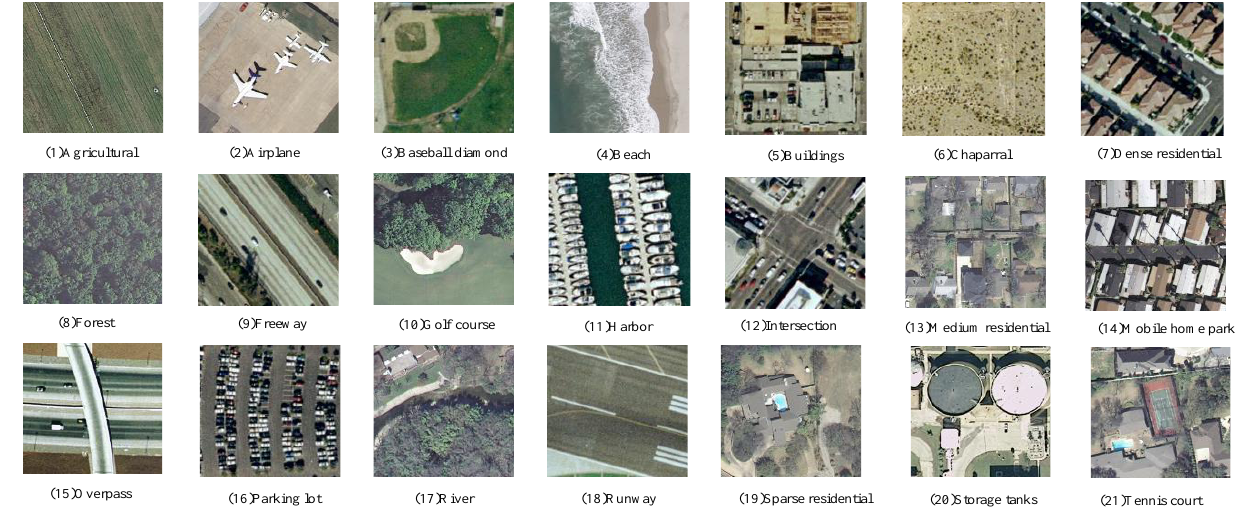
Figure 3. Some samples from the UC Merced Land-Use Dataset (UCM21) dataset.